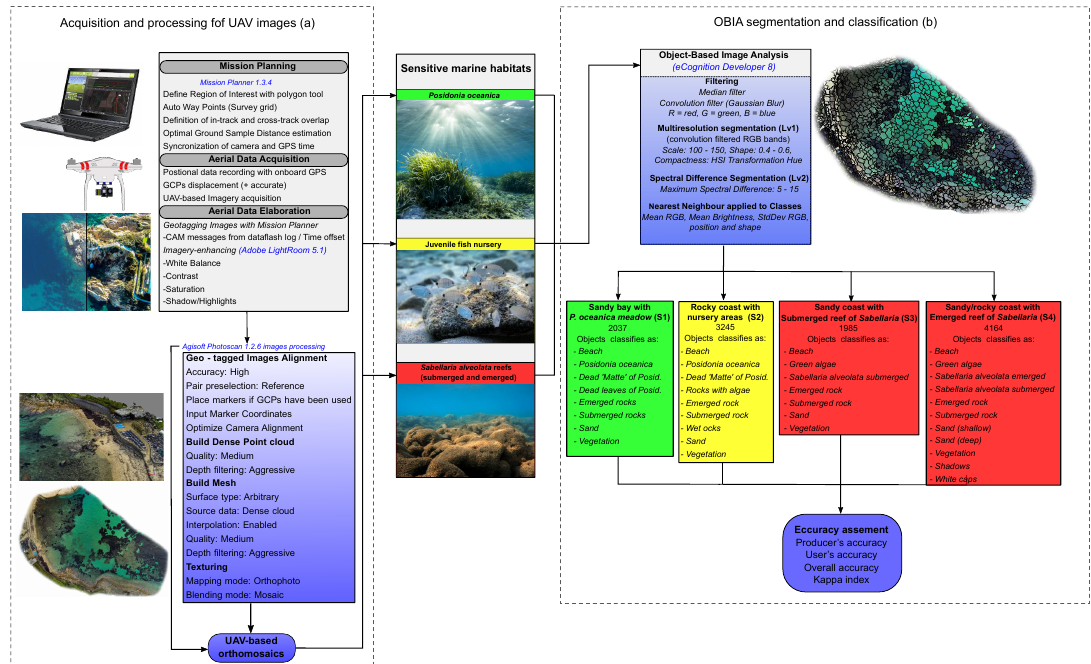
Figure 4. Typical acquisition and processing pipeline regarding acquisition, planning and processing of UAV-based aerial images ( a ) and object-based image analysis (OBIA) segmentation and classification of marine habitats ( b